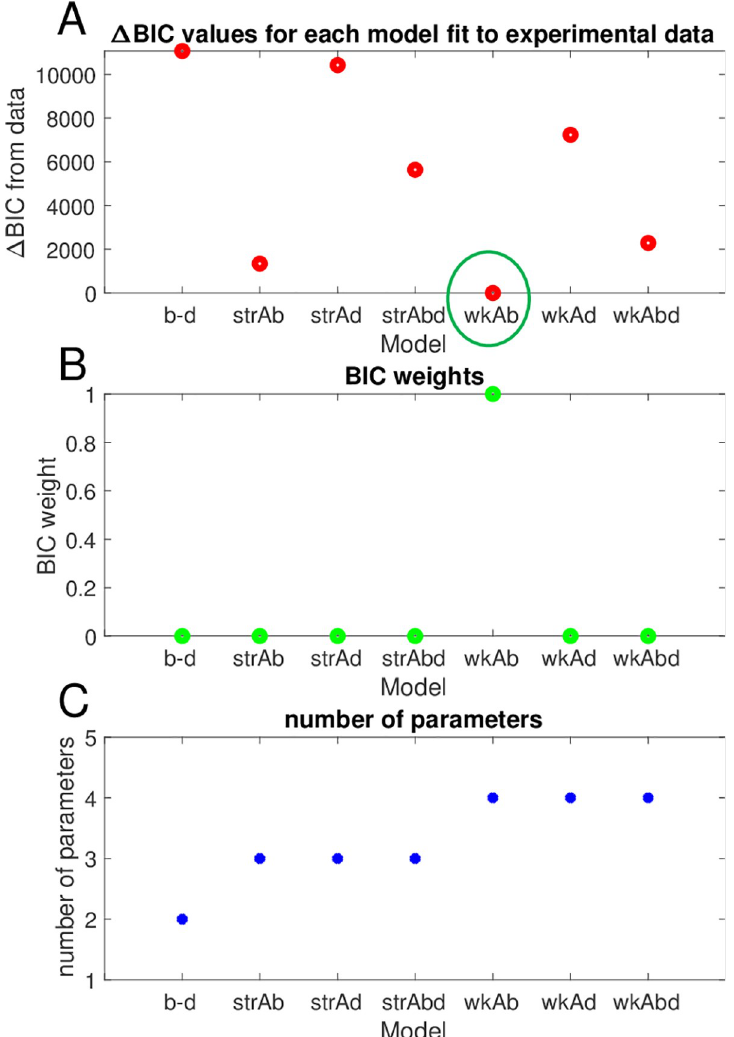
Fig 8. Weak Allee model on birth best describes BT-474 in vitro growth data. (A) Δ BIC values for the fit of the data to each of the 7 candidate stochastic growth models shows that the weak Allee model on birth exhibits the lowest BIC value. (B) BIC weights for each model indicate that the weak Allee model on birth is significantly better than all other models. (C) Number of parameters in each model as a measure of model complexity. The data and code used to generate this figure can be found at https://github.com/brocklab/Johnson-AlleeGrowthModel.git. BIC, Bayesian Information Criterion.